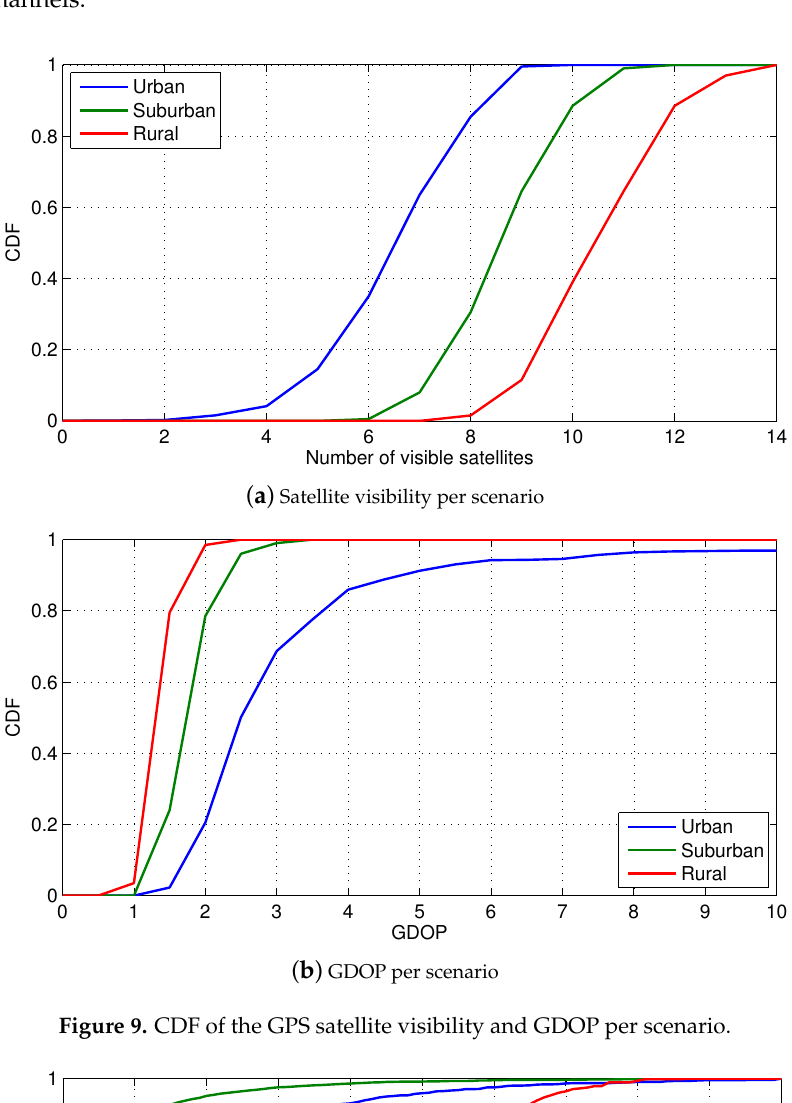
Figure 9. CDF of the GPS satellite visibility and GDOP per scenario.